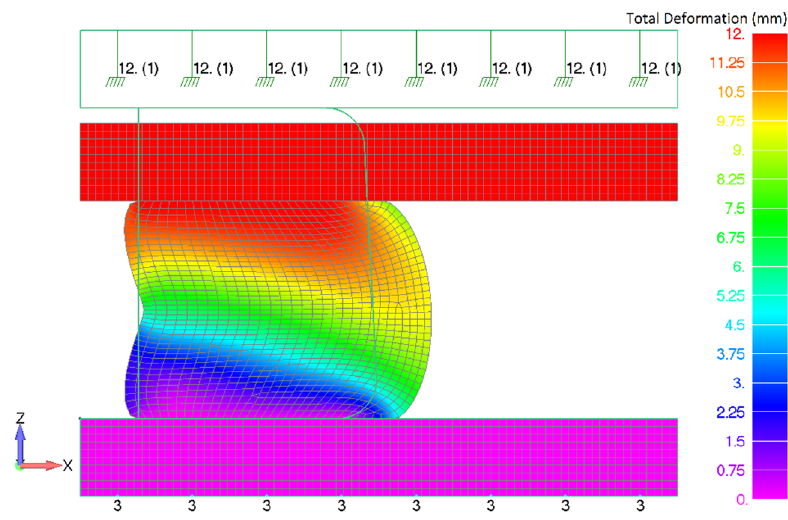
Figure 2. The finite element model of the rubber bumper and the obtained deformation state at 12 mm prescribed displacement.